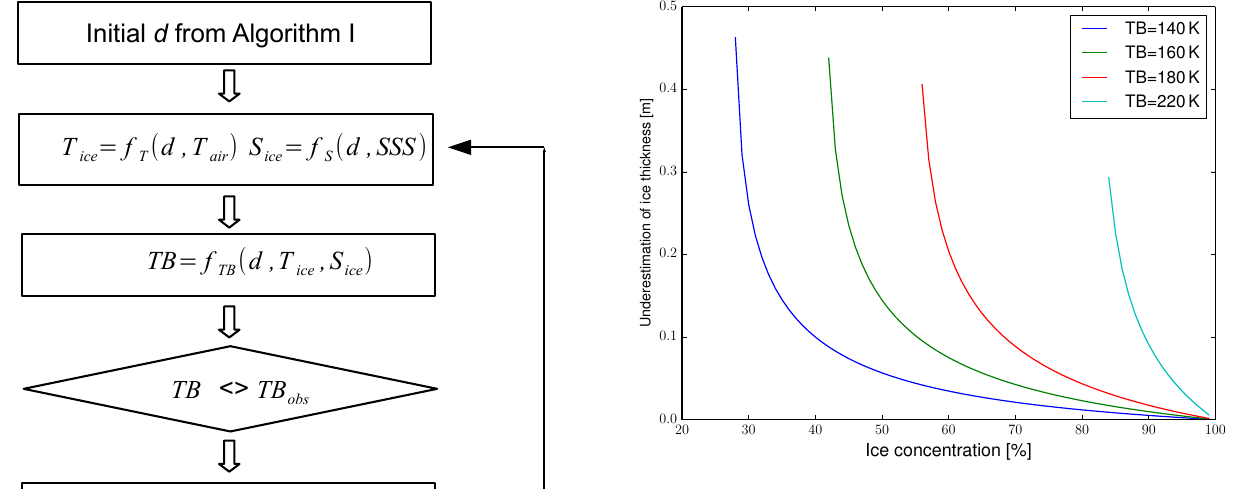
Figure 8. The underestimation of ice thickness caused by the 100% ice coverage